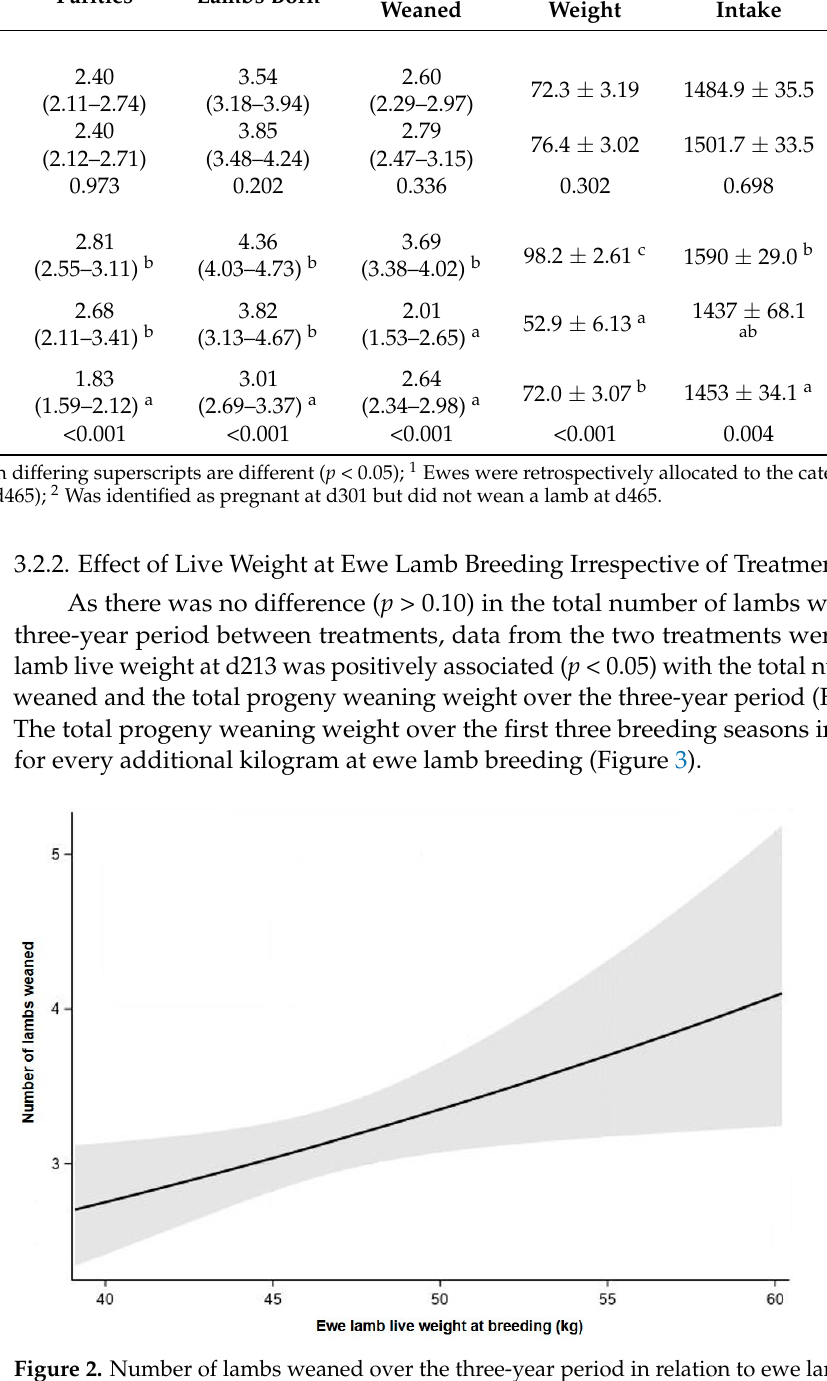
Table 4. The effect of treatment (control vs. heavy) and ewe lamb status at d465 1 (weaned a lamb, failed to wean a lamb 2 , non-pregnant) on least-square means (95% confidence intervals) of the total number of parities, lambs born and weaned over the first three years of production, and least-square means ( ± SEM) of total progeny weaning weight (kg) over the three-year period, total predicted pasture intake (kg DM) between weaning of the ewe (d86) and the weaning of the third litter (d1159), and estimated feed efficiency (total progeny weaning weight/total predicted pasture intake; kg/kg DM) over the first three years of production.